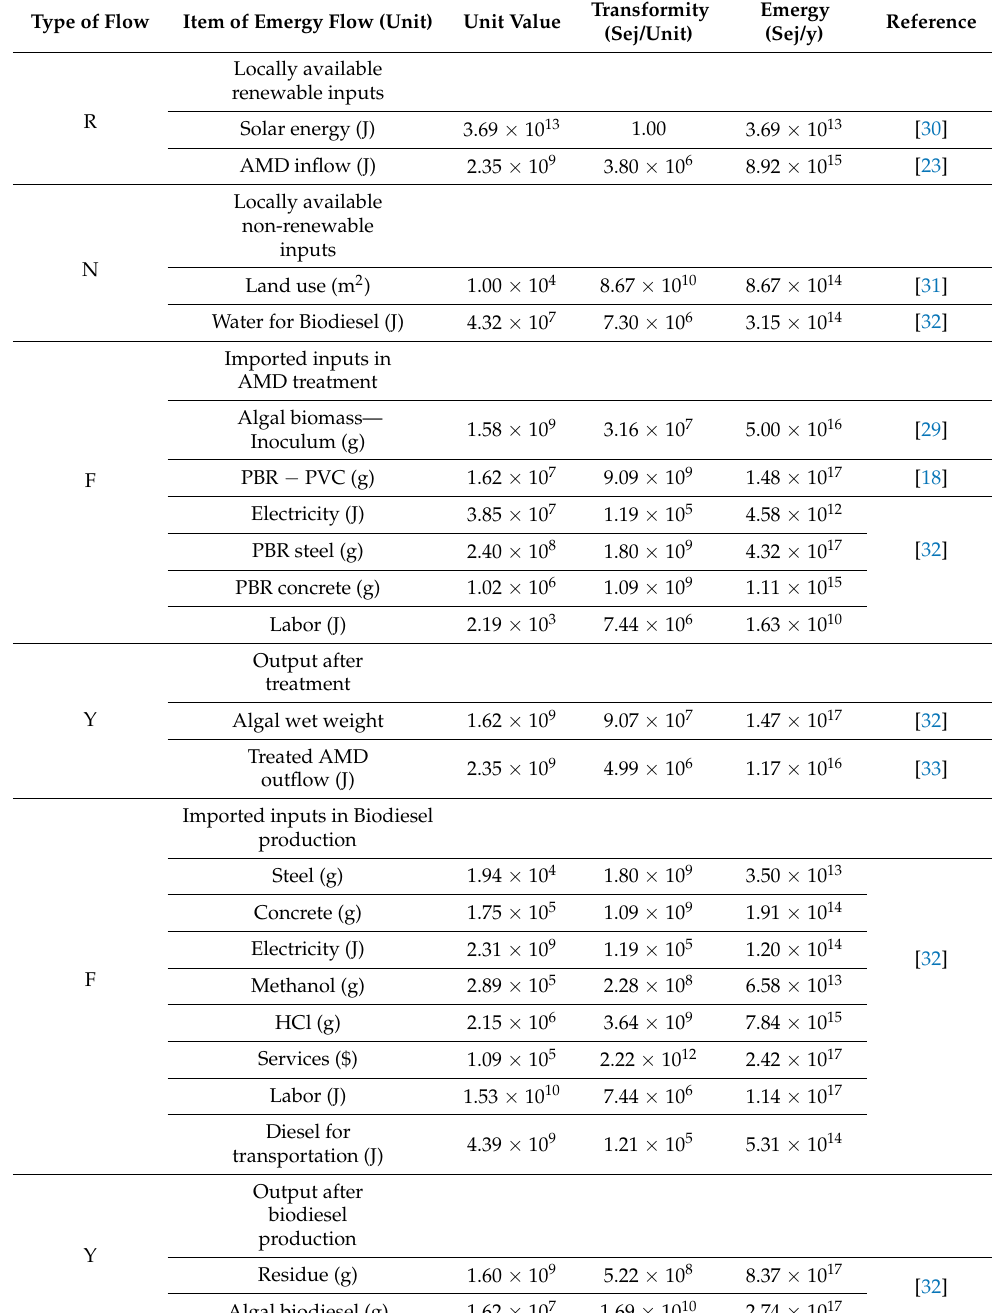
Table 1. Emergy calculations for microalgae-based AMD treatment and biodiesel